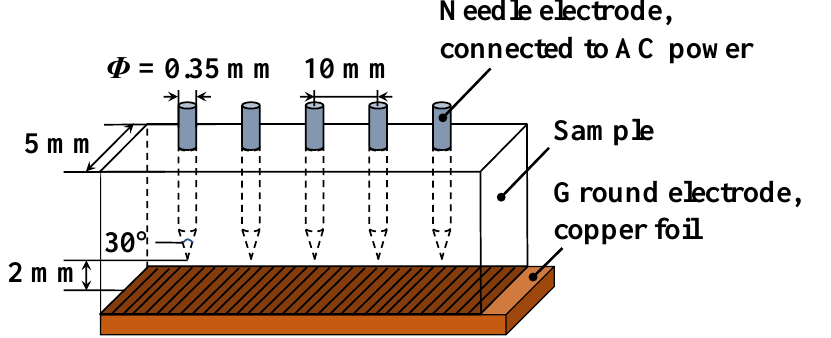
Figure 2. Electrical tree sample model.